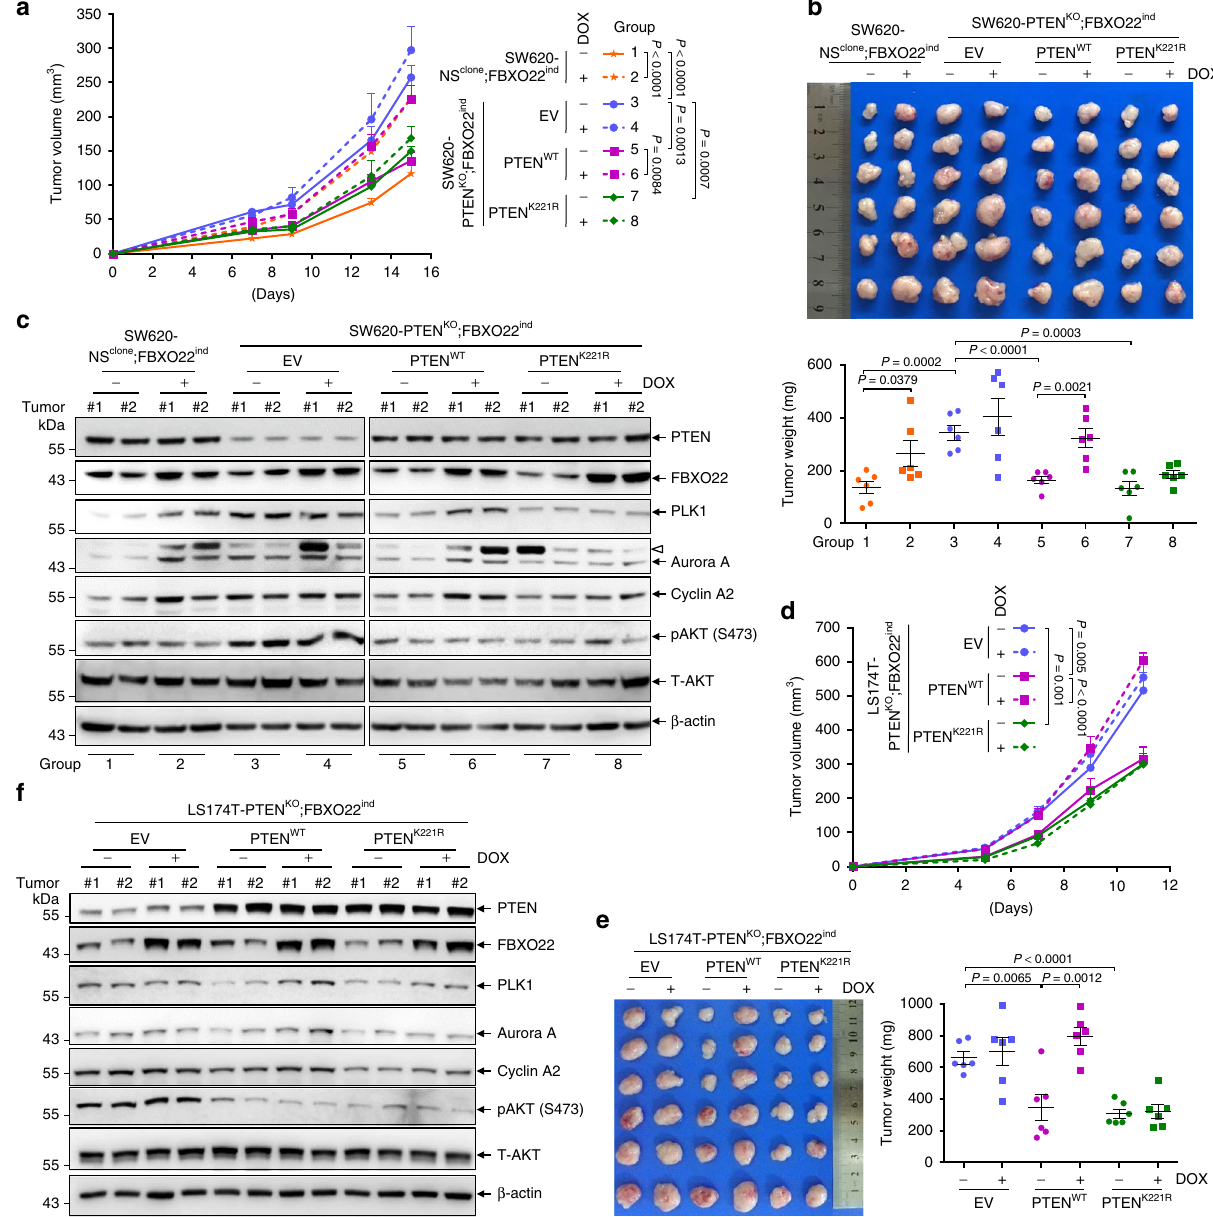
Fig. 6 FBXO22 exerts tumor-promoting role through degradation of nuclear PTEN. a – c SW620-NS clone ;FBXO22 ind infected by retroviruses encoding empty vector (EV) and SW620-PTEN KO ;FBXO22 ind cells infected by retroviruses encoding EV, PTEN WT and PTEN K221R were subcutaneously injected into nude mice (1.5 × 10 6 cells per mouse). Once inoculated, mice were administrated with or without 600 mg/kg DOX in feed. Tumor volumes were measured at different days ( a ). On day 15 after subcutaneous injection, tumors were harvested, weighted ( b ), and two tumors from each group were randomly selected for Western blot analysis ( c ). The empty triangle points to an unknown band. d – f LS174T-PTEN KO ;FBXO22 ind cells were infected by retroviruses encoding EV, PTEN WT and PTEN K221R followed by subcutaneous injection into NOD-SCID mice (1.5 × 10 6 cells per mouse). Right after inoculation, mice were administrated with or without 600 mg/kg DOX in feed. Tumor volumes were measured at different days ( d ). On day 11 after subcutaneous injection, tumors were harvested and weighted ( e ), and two tumors from each group were randomly selected for Western blot analysis ( f ). All experiments were repeated three times with similar results, and the results of one representative experiment are shown. The data in panels a , b , d , e are presented as the mean ± SEM, n = 6 biologically independent samples, and in panels c , f , tumors ( n = 2) were randomly selected from each group; two-way ANOVA for a , d and two-tailed unpaired t -test for b , e . Source data are provided as a Source Data fi